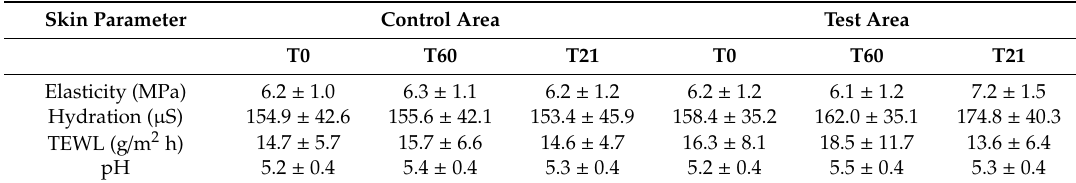
Table 2. Paired statistical values of elasticity, hydration, TEWL and pH ( n = 30; statistically significant values in Figure 3. Elasticity measurements of the control and test area in the short-term and long-term study (grey boxes are test values, white are control).